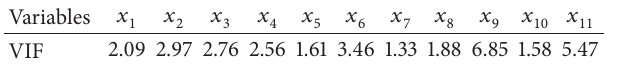
Table 2: Collinearity diagnosis for LR